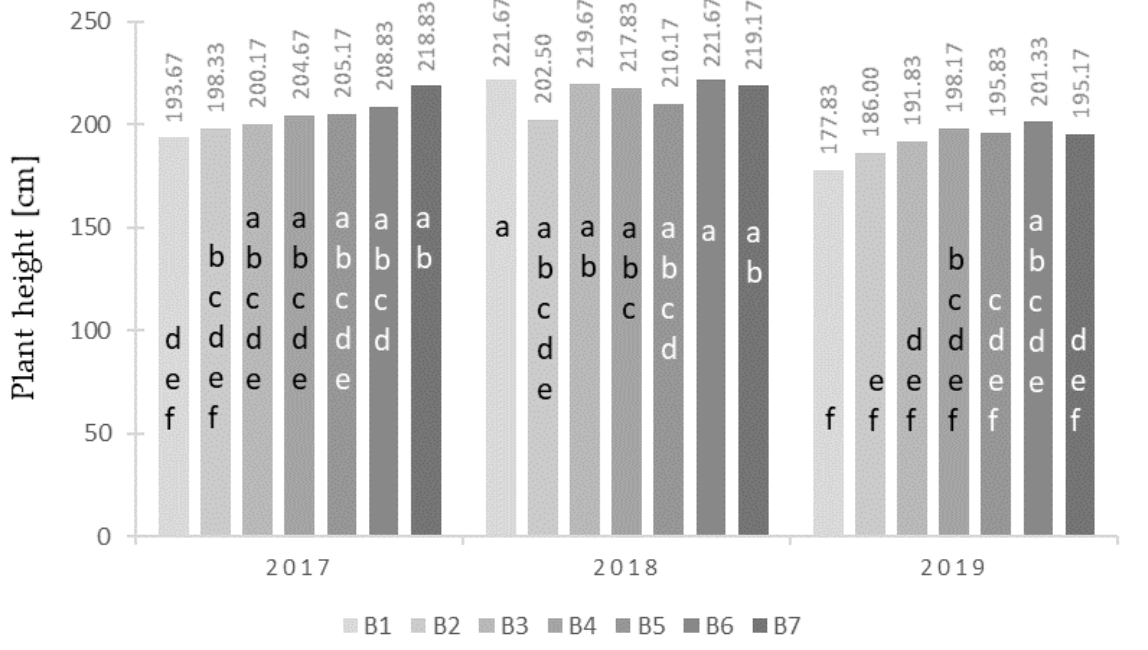
Figure 1. Average values of plant height [cm] for the combination of years (Y) and fertilizer (B). Values marked with the same letter do not differ significantly ( p = 0.0278).